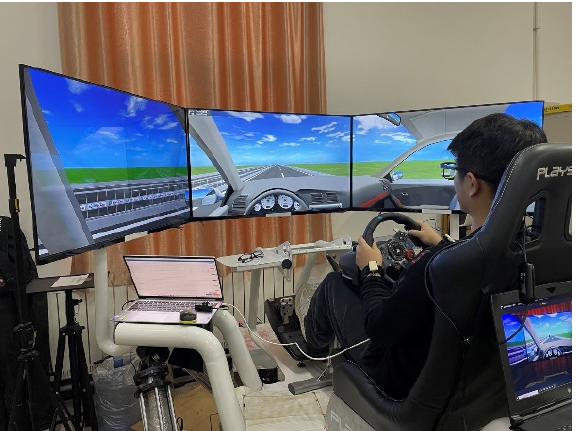
Figure 1. Experiments of simulated driving.